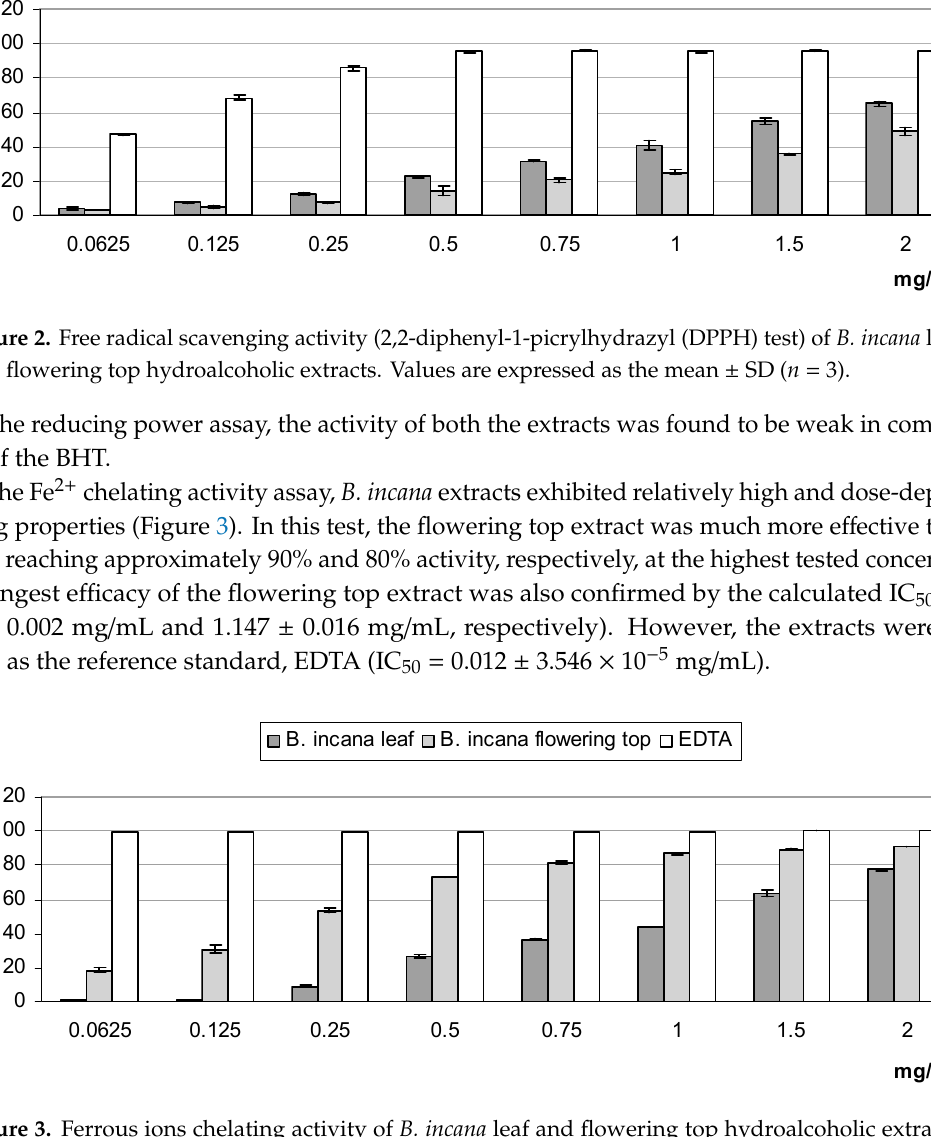
Figure 3. Ferrous ions chelating activity of B. incana leaf and flowering top hydroalcoholic extracts. Values are expressed as the mean ± SD ( n = 3).